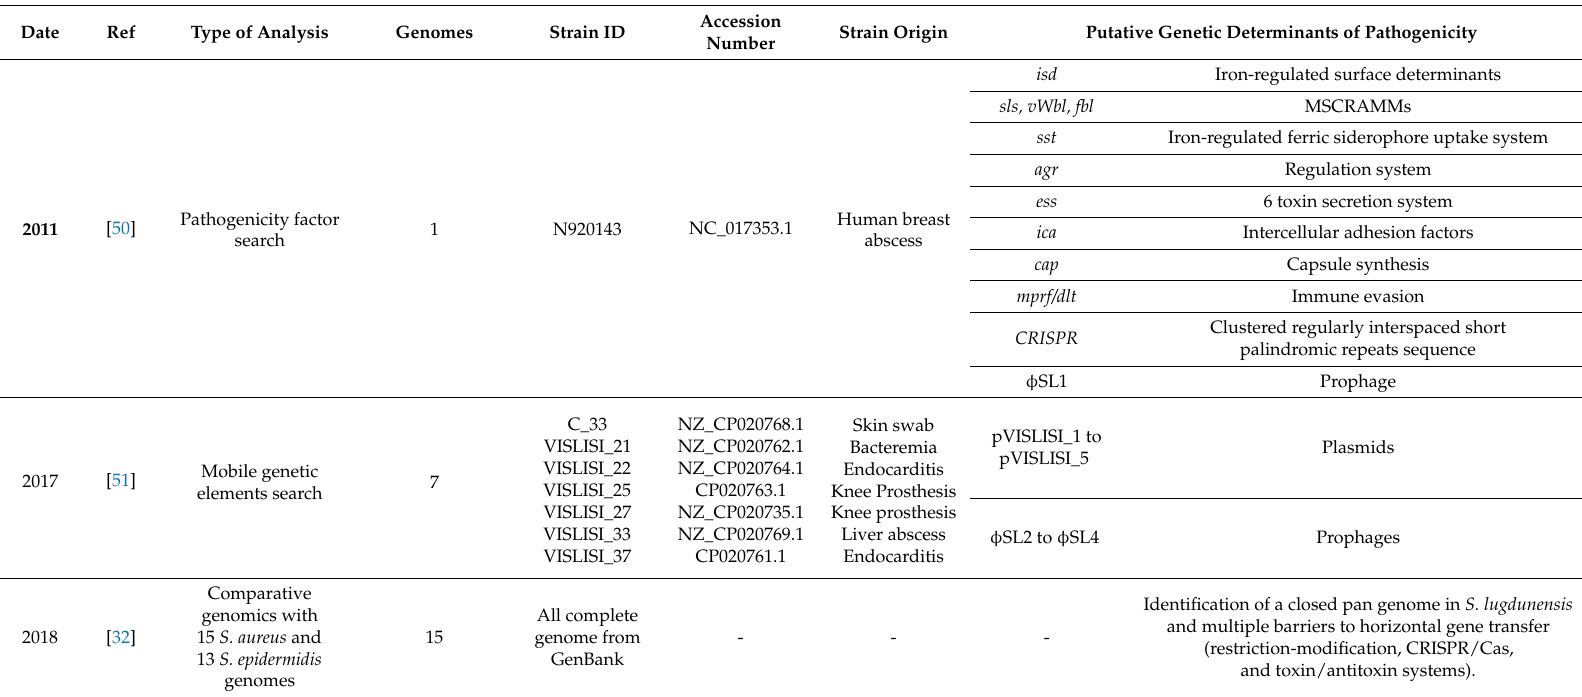
Table 2. Staphylococcus lugdunensis whole-genome-based studies to determine virulence